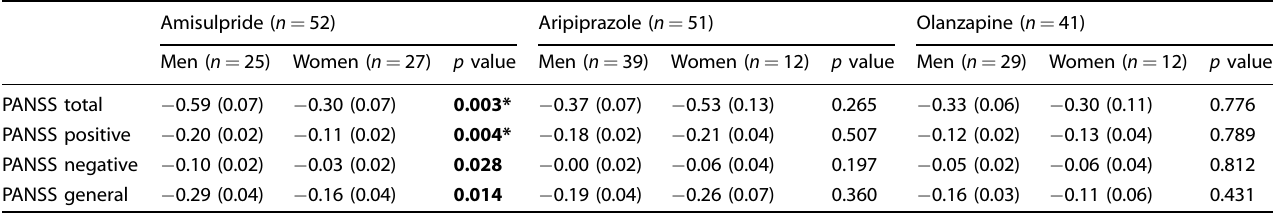
Table 2. Comparison between men and women for PANSS score